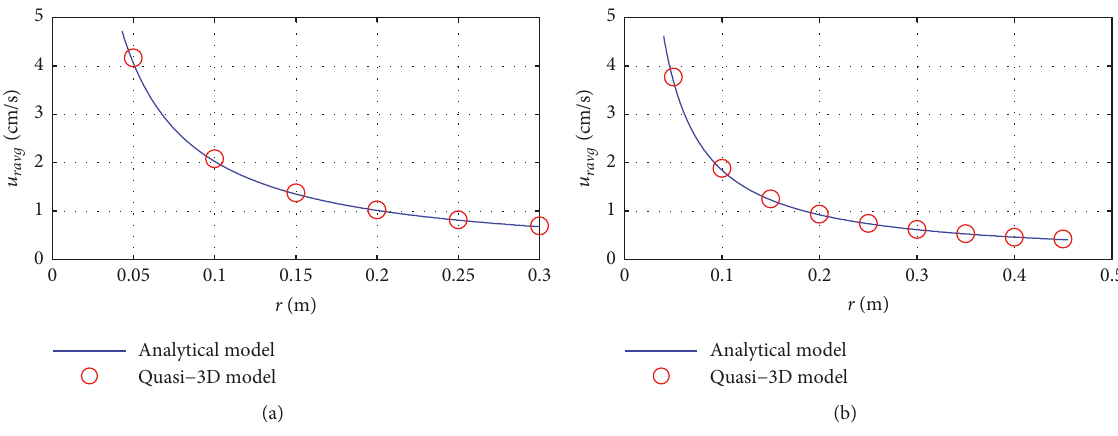
Figure 15: Distribution of average flow velocity over radius at different times in Case 2 (a) t = 20 s; (b) t = 50